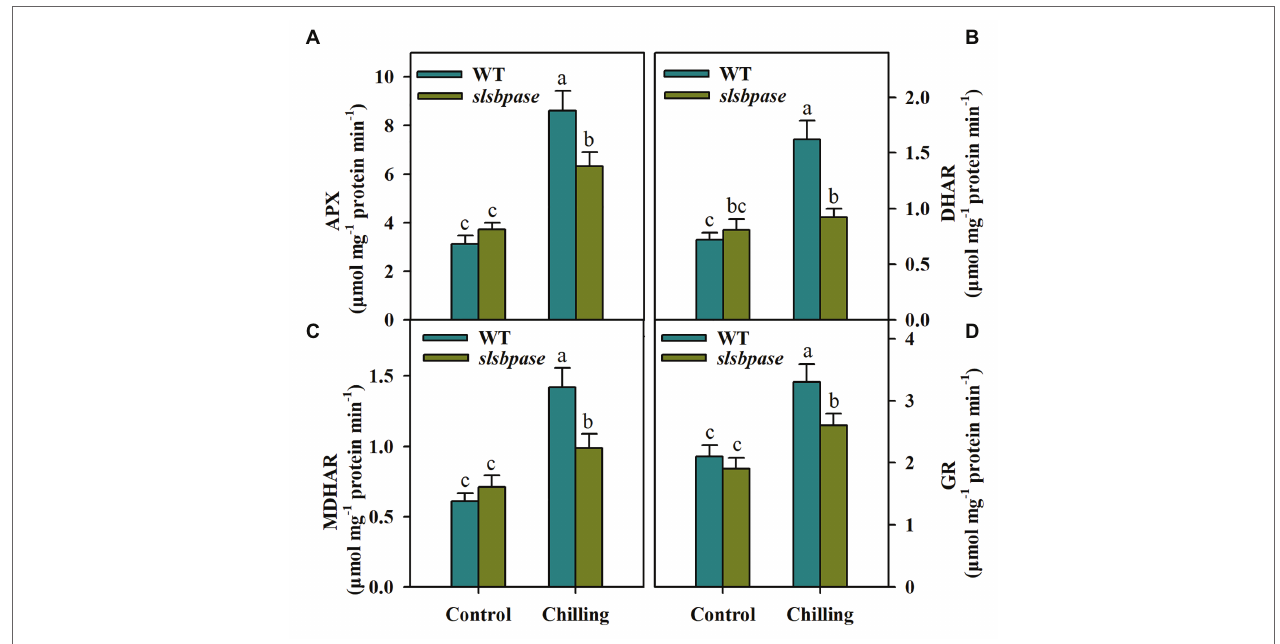
FIGURE 5 | Activities of enzymes involved in the AsA-GSH pathway as affected by SlSBPASE mutation in chilling-stressed tomato plants. (A) Ascorbate peroxidase (APX); (B) dehydroascorbate reductases (DHAR); (C) monodehydroascorbate reductase (MDHAR); and (D) glutathione reductases (GR). At the fourth- leaf stage, slsbpase mutants and wild-type plants were subjected to a 24 h chilling stress. Following that, leaves from different groups were sampled for the determination of enzyme activities. The results are mean values ± SDs from three independent experiments, and different letters on top of each column represent significantly different values at p < 0.05 among